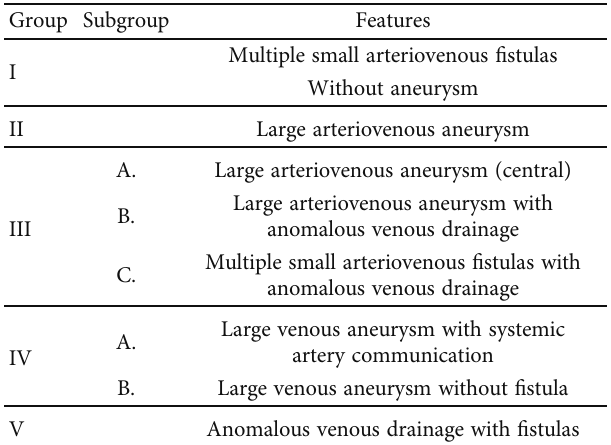
Table 1: Classi fi cation of pulmonary arteriovenous malformations [3,